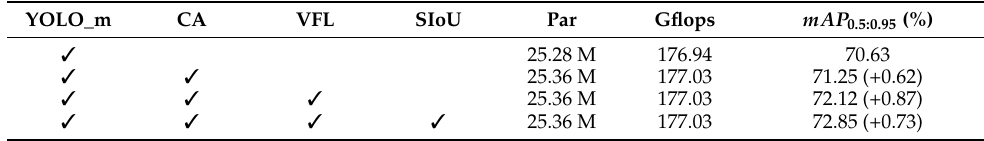
Table 6. Performance of the improved YOLOX_m